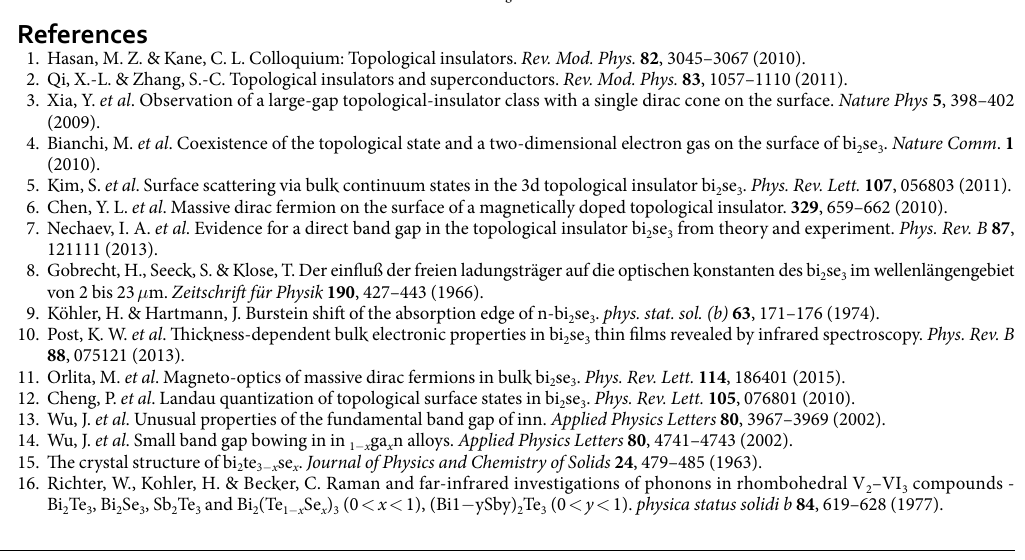
= 22.0 ± 0.5 T and F = 28.0 ± 0.5 T for A B